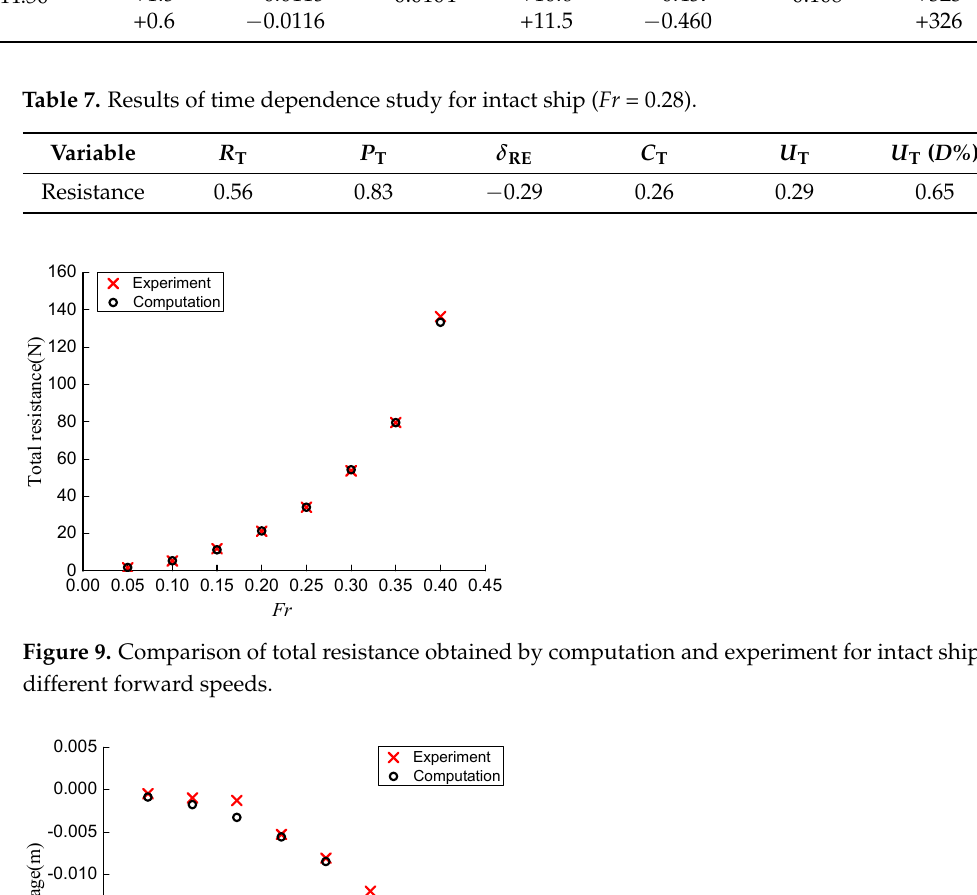
Table 6. Total resistance, sinkage and trim obtained by three time steps for intact ship ( Fr = 0.28).